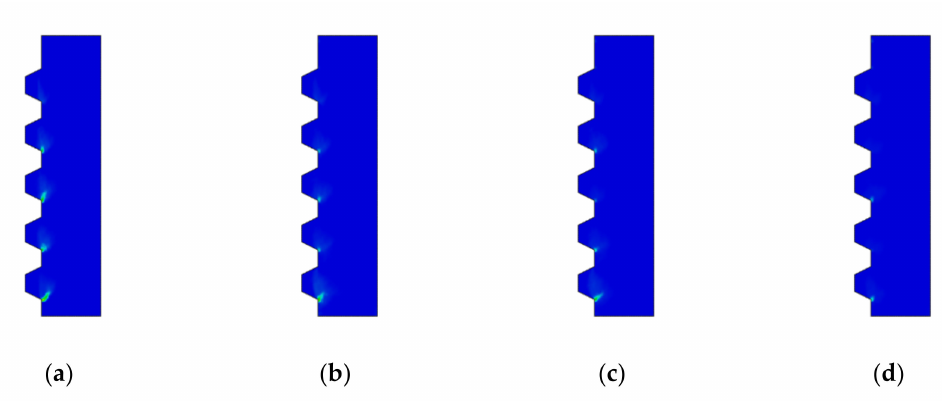
Figure 10. Damage evolution in a 5-keyed joint with σ n = 0.5 MPa: ( a ) V f = 0.0%; ( b ) V f = 0.5%; ( c ) V f = 1.0%; ( d ) V f = 1.5%.